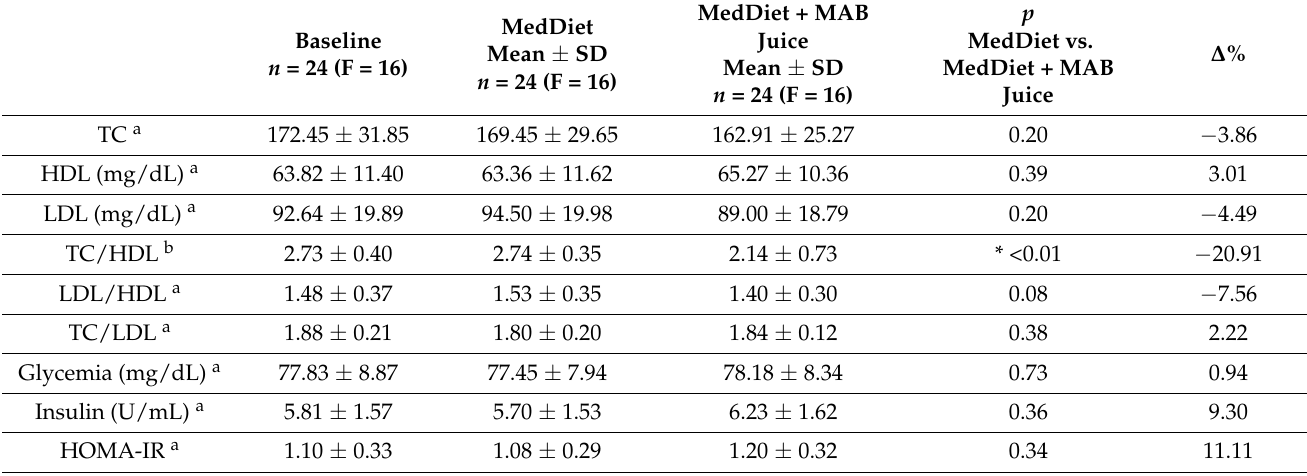
Table 4. Comparison of blood chemistry values between MedDiet and MedDiet + MAB juice